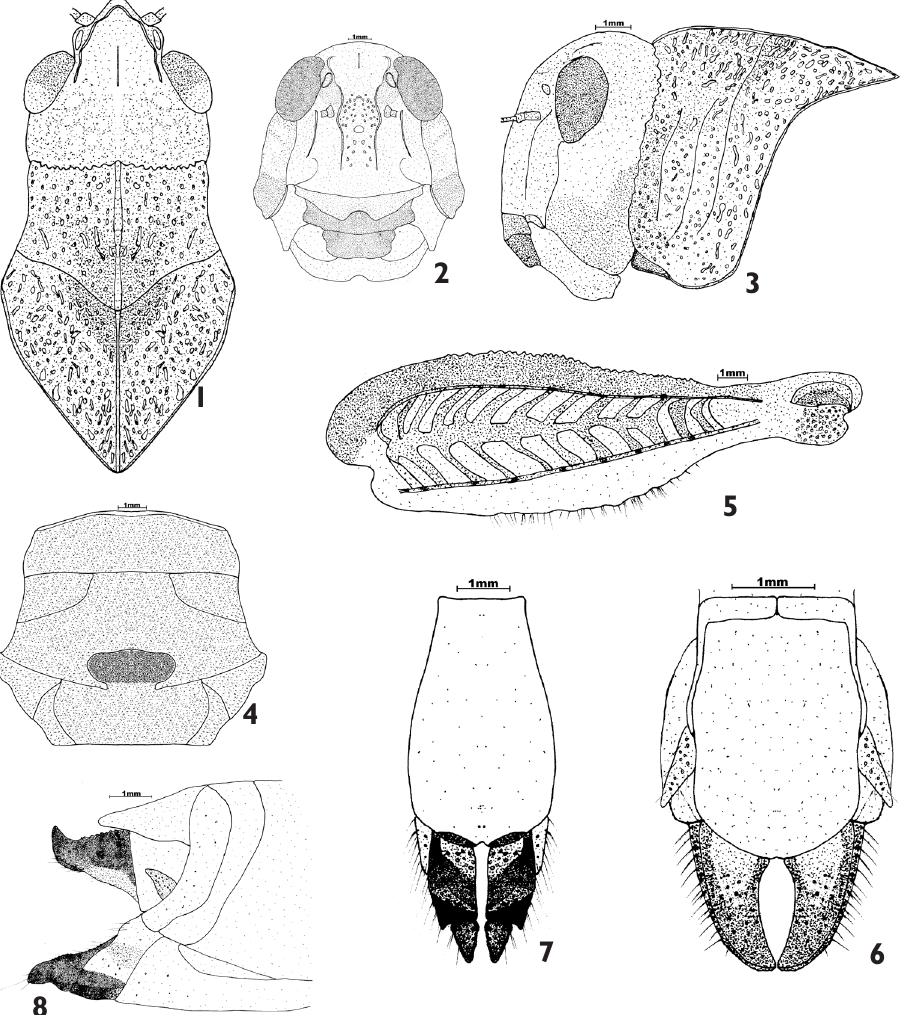
Figures 1–8. ♀ Pycnodictya galinieri galinieri . 1 dorsal view of head and pronotum 2 lateral view of head and pronotum 3 anterior view of head 4 ventral view of meso- and metasternum 5 external side of hind femur 6 dorsal view of abdominal apex 7 ventral view of abdominal apex 8 lateral view of abdominal apex.